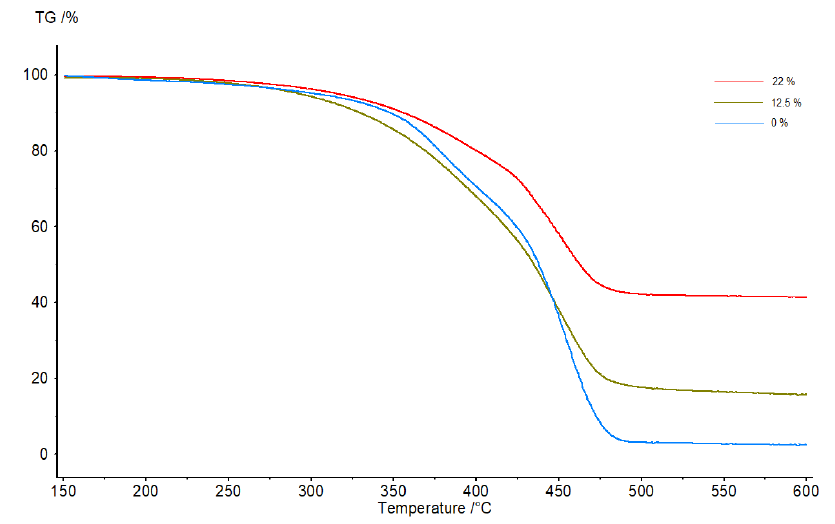
Figure 4. The TGA curves of epoxy resins with an increasing amount of KL MeOH (expressed as weight %).